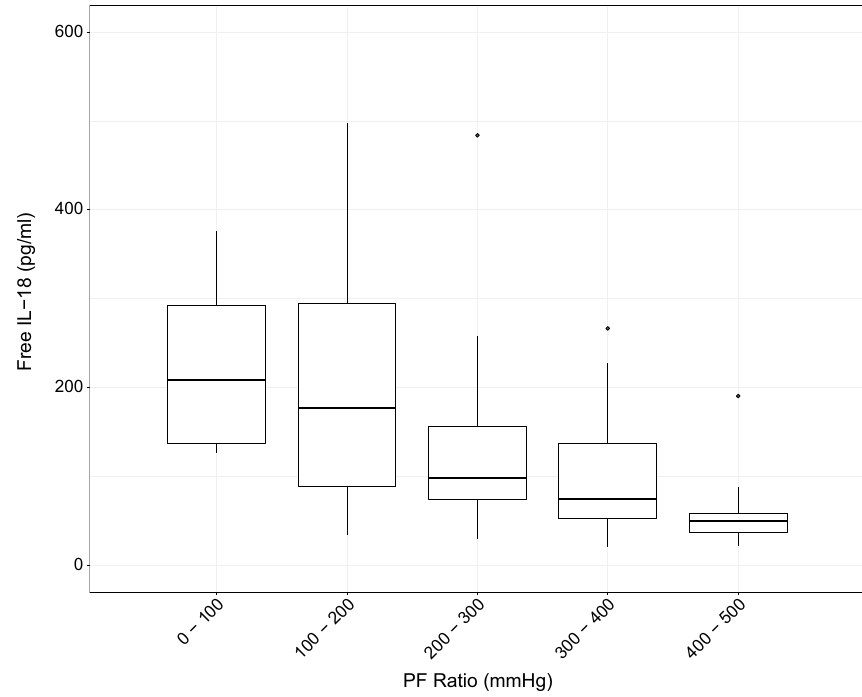
Fig. 3 PaO 2 /FiO 2 ratio (PFR) vs. Highest Free IL-18 (fIL-18) from symptom day 15 onwards. Highest fIL-18 per patient ( n 97) from symptom day 15 onwards shows an inverse, statistically significant relationship with = concurrent PFR (primary outcome), divided into bins as per the Berlin Criteria for acute respiratory distress syndrome (ARDS) severity categories, and extended above 300 mmHg. Multivariate adjusted linear regression shows an increase of 37.7 pg/ml in highest fIL-18 for each decrease in PFR by 100 mmHg (13.3 kPa) ( p <